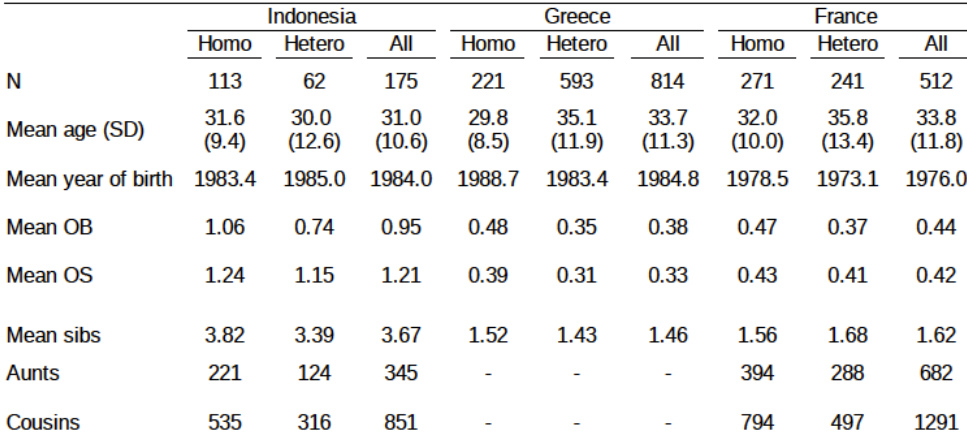
Table 2. Descriptive statistics for the three population samples of individual family data. The Greek and